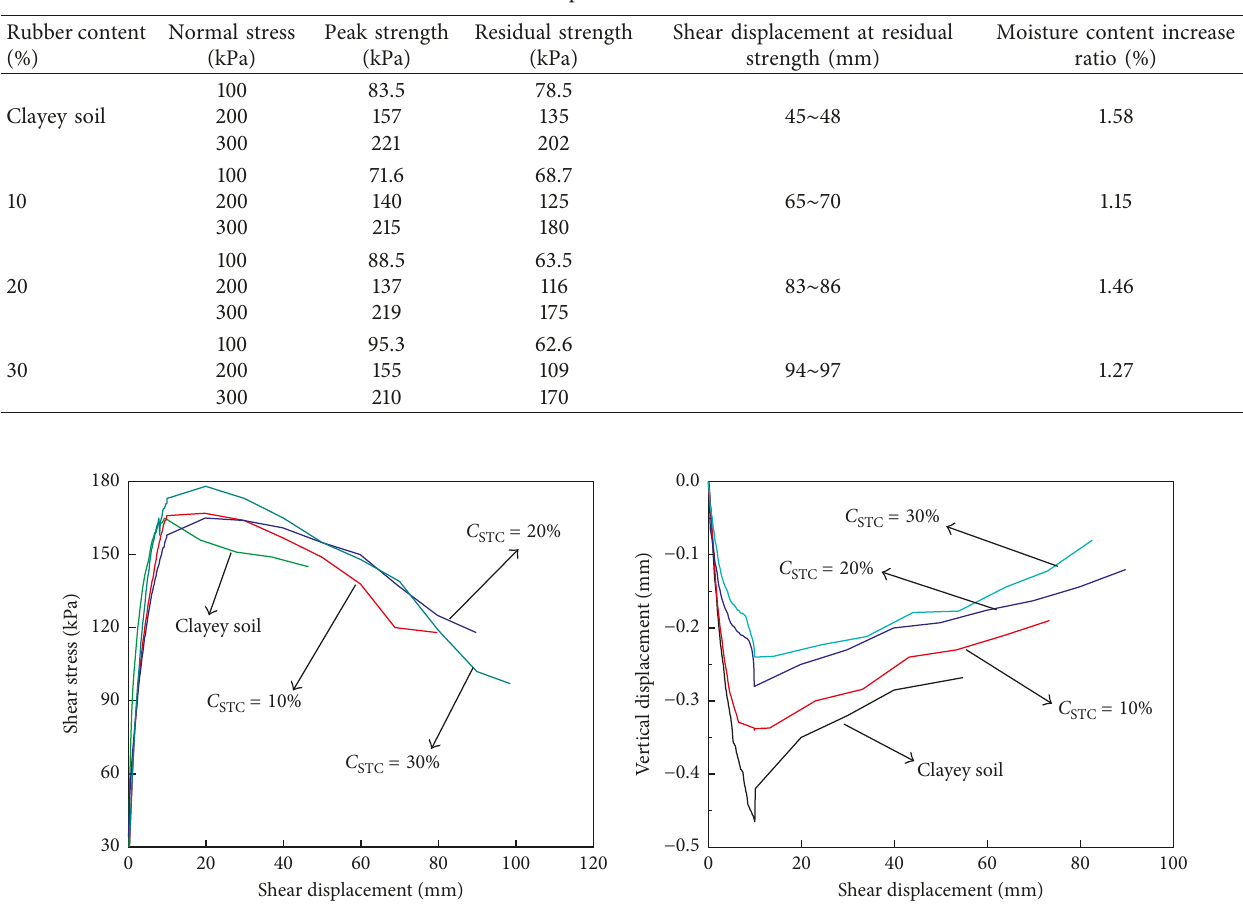
Table 4: The results of repeated direct shear tests for mixtures.